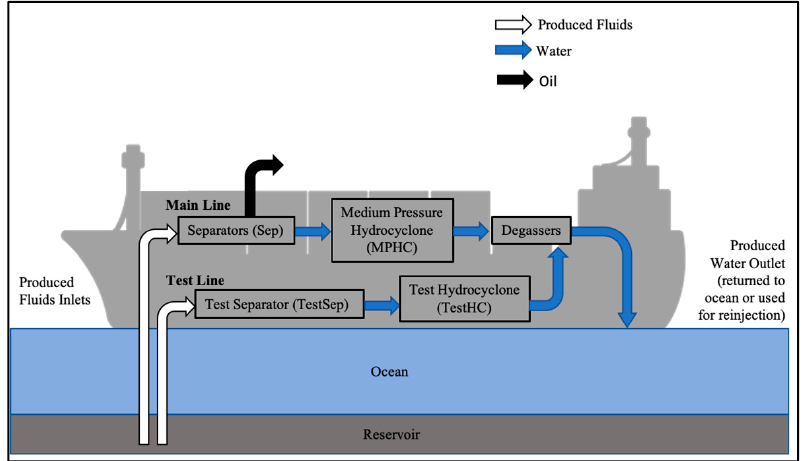
Figure 1. A generalized schematic of the flow path of the produced fluids through an FPSO platform. Both Platforms A and B described in this study follow this general flow path.